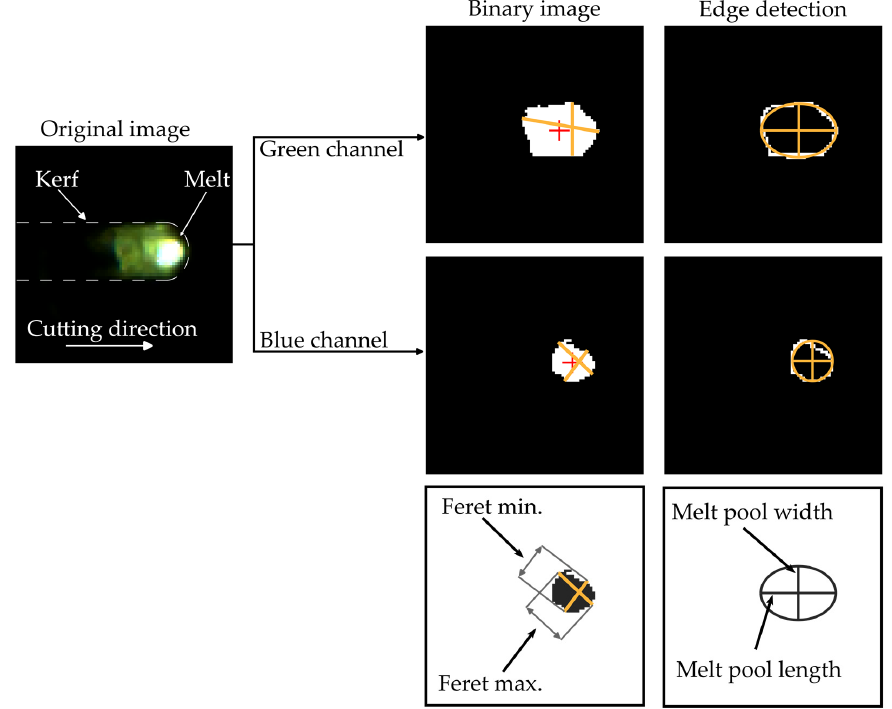
Figure 2. Illustration of the image processing steps. The original image and the corresponding binary image with the calculated ferret diameter and the edge detection image with the length and width of the melt pool, respectively, for the green and blue channels.